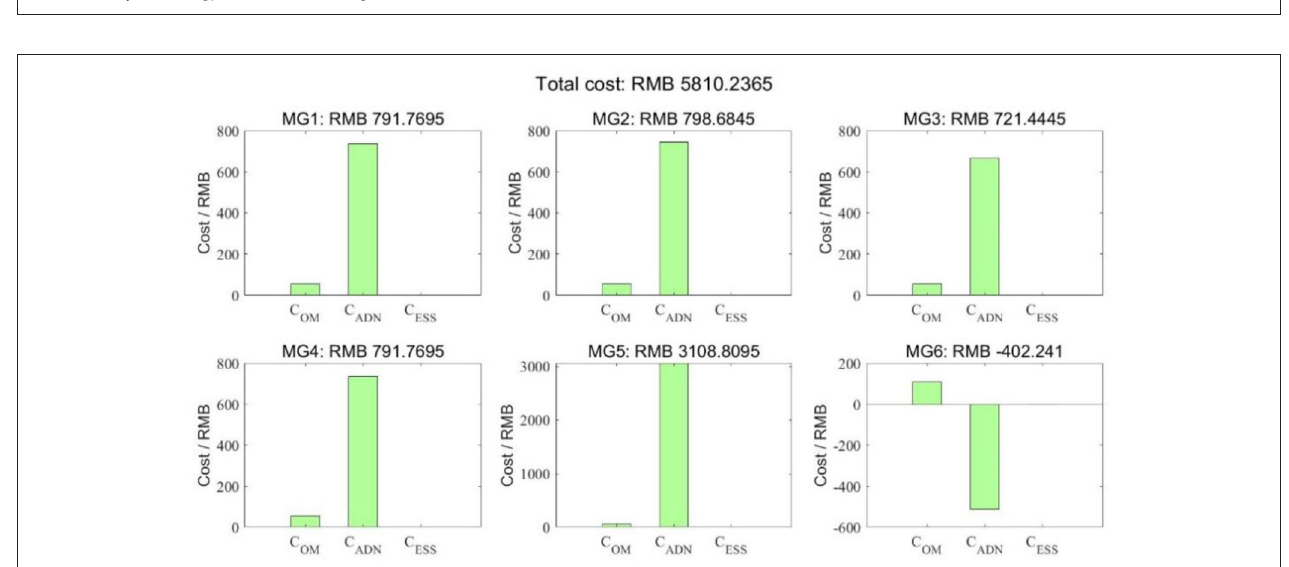
FIGURE 10 | The energy bills of each microgrid within the cluster in scenario 5.